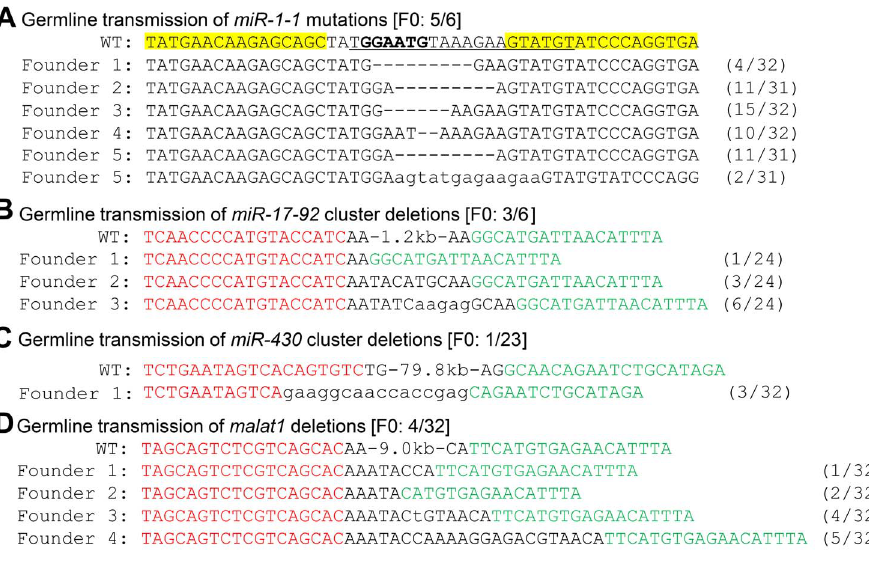
Figure 4. Germline transmission of the knockout genotypes. ( A ) Germline transmission of the miR-1-1 mutations. The TALEN binding sites are shown in yellow background. DNA sequence encoding the mature miR-1-1 is underlined, with the seed sequence in bold. Deletions are indicated by dash lines and insertions are indicated by lowercase letters. The F0 germline deletion ratio is shown in square brackets. The ratios of mutated/total analyzed sequences from the pooled F1 embryos of each founder are shown in brackets. ( B – D ) Germline transmission of the miR-17-92 deletions ( B ), miR-430 deletions ( C ) and malat1 deletions ( D ). The F0 germline deletion ratios are shown in square brackets and the F1 inheritance ratios are shown in brackets.